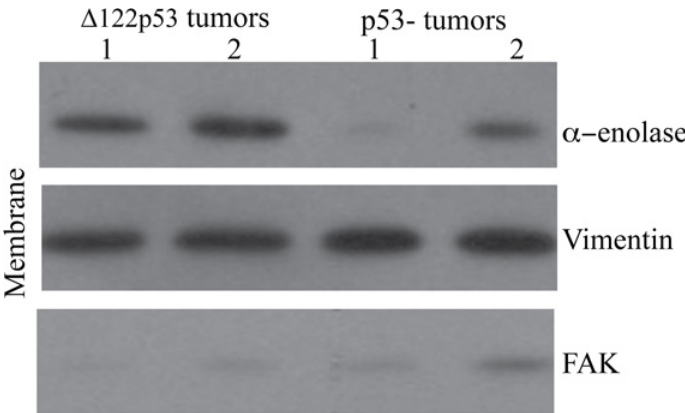
Figure 4. Increased α -enolase on the Δ 122p53 tumor cell membrane. Tumors from Δ 122p53 mice had increased alpha-enolase at the cell surface compared to tumors from p53- mice. Sarcomas were dissected from Δ 122p53 and p53- mice at necropsy, the cytosolic and cell membrane fractions were separated, and these fractions were subjected to western blotting using an antibody to alpha-enolase. The cell membrane results from two tumors per genotype (1 and 2) are shown. Western blotting for vimentin was used as a loading control for the mesenchymal cell membrane fraction and FAK was included to control for cytosolic contamination in cell membrane